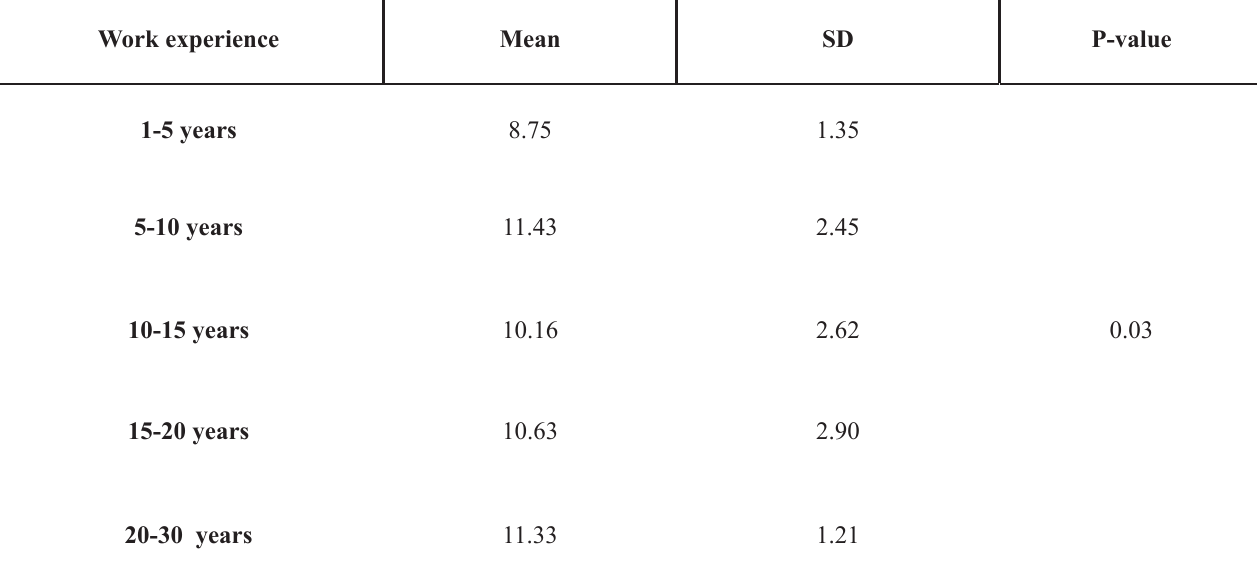
Table 5. Scores of knowledge of medical staff about the principles of radiation protection in terms of Work experience.